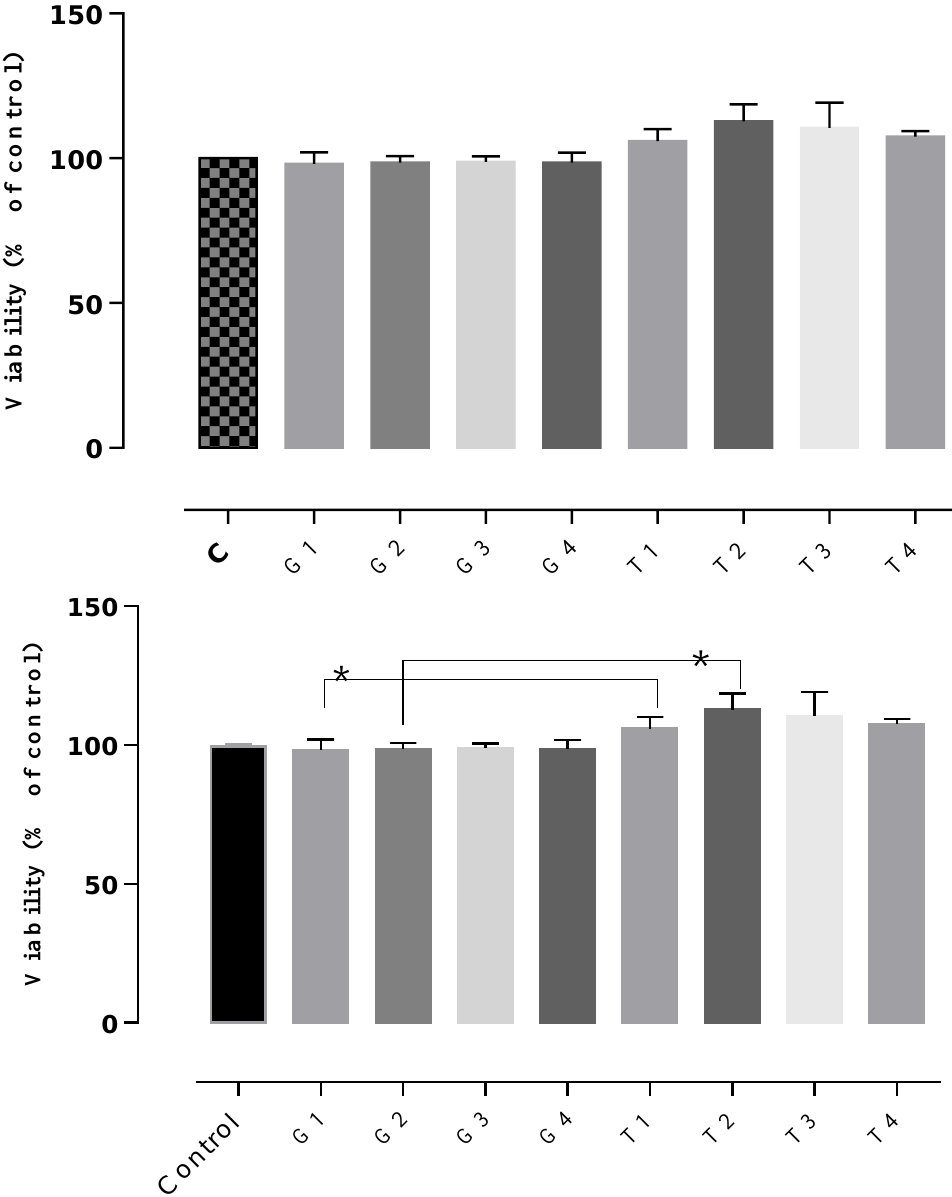
Figure 8. D1MSCs cells viability assessment after treatment with control gel and gel with Thieves ® essential oil, where Control = D1MSCs cells in normal propagation medium; G1, 2, 3, 4 = the gel without essential oil in 4 different concentrations (2.4; 4.7; 7 and 9% ( v / v )); T = the gel with Thieves ® essential oil in 4 different concentrations of gels (2.4; 4.7; 7 and 9% ( v / v )), * p < 0.05.